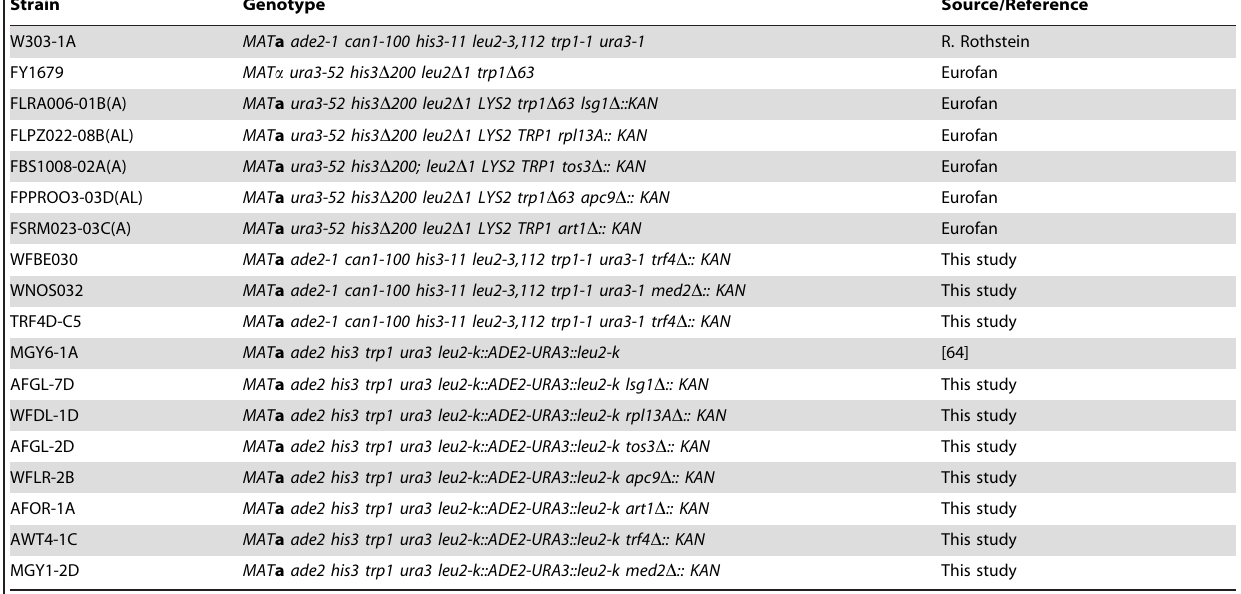
Table 1. Table of Strains used in this work.